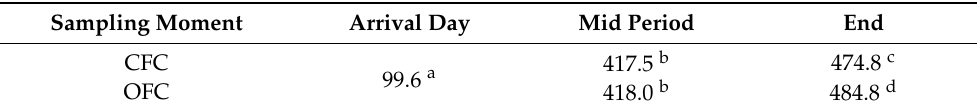
Table 2. Alpha diversity (Chao 1 index) according to the moment of the growing period in commercial (CFC) and optimal (OFC) farm